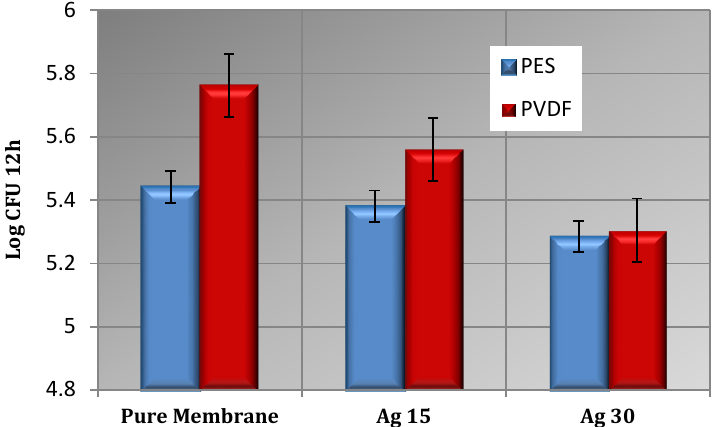
Figure 8. Impacts of pure and nanocomposite membranes on colony forming units counting. (Error bars were based on the standard deviations of three replicate measurements obtained from three sets of independent cultivated bacteria mixed with three independent membranes.)